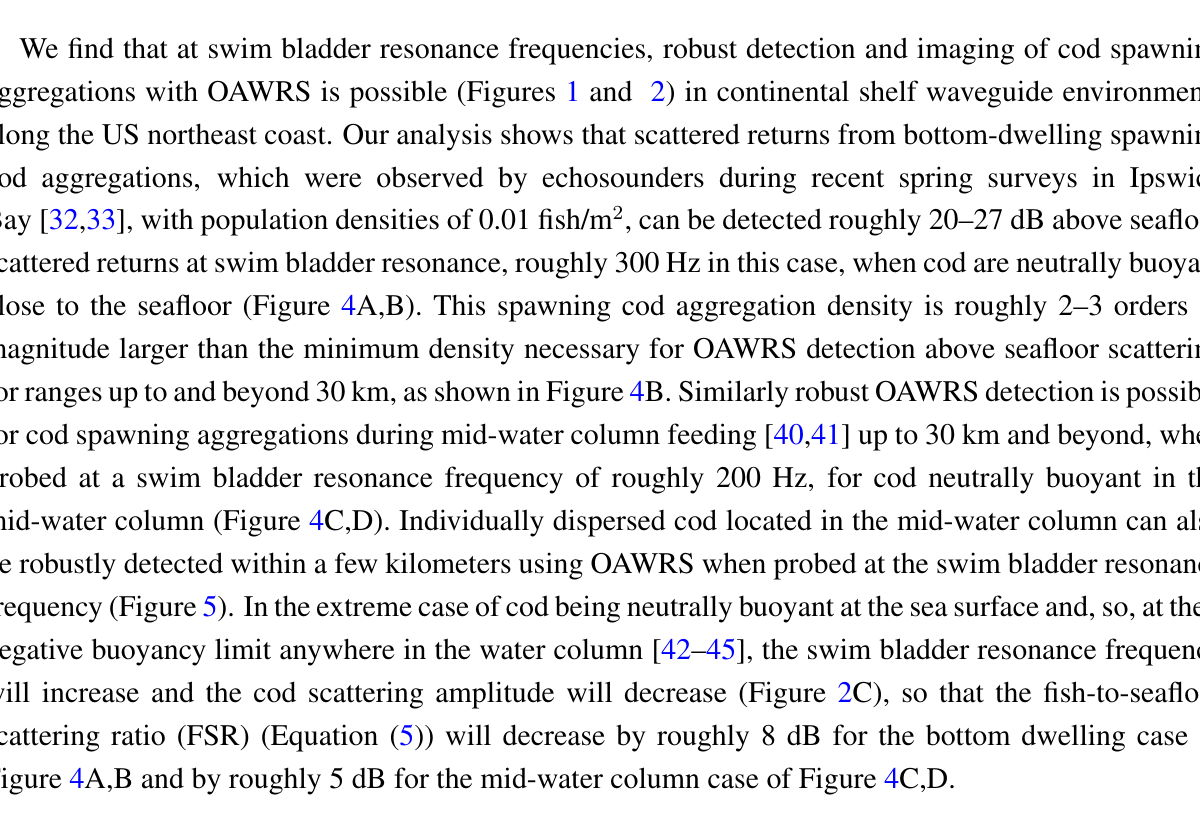
New Jersey shelf: f 2.7 Georges Bank: f